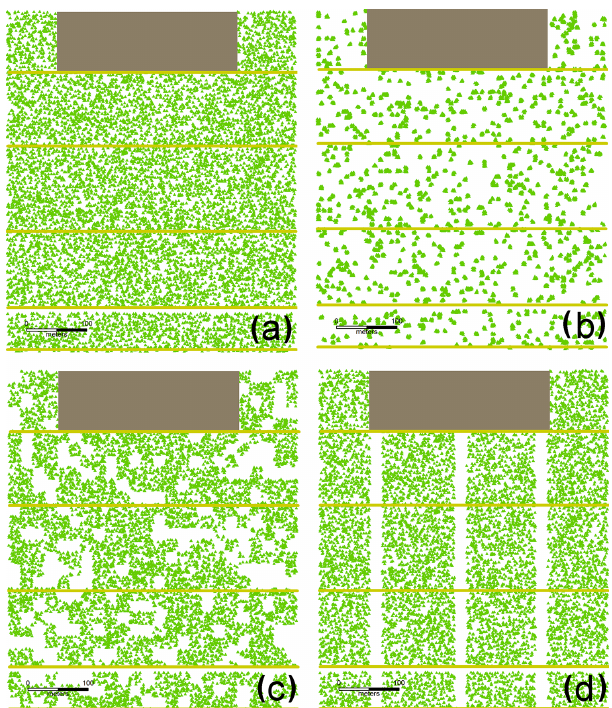
Figure 3. Design of forest structures, release area of rockfalls (grey rectangle) and evaluation lines (EL) for simulation runs. For each forest type, we considered four different scenarios regarding the horizontal forest structure. Forest type 1 is illustrated in (a) with a random tree distribution, (b) with a random distribution of trees in clusters of 10 trees, (c) with a distribution of trees with random gaps (minimum 20 × 20m) and (d) with three aisles of 20m in width starting below the release area of